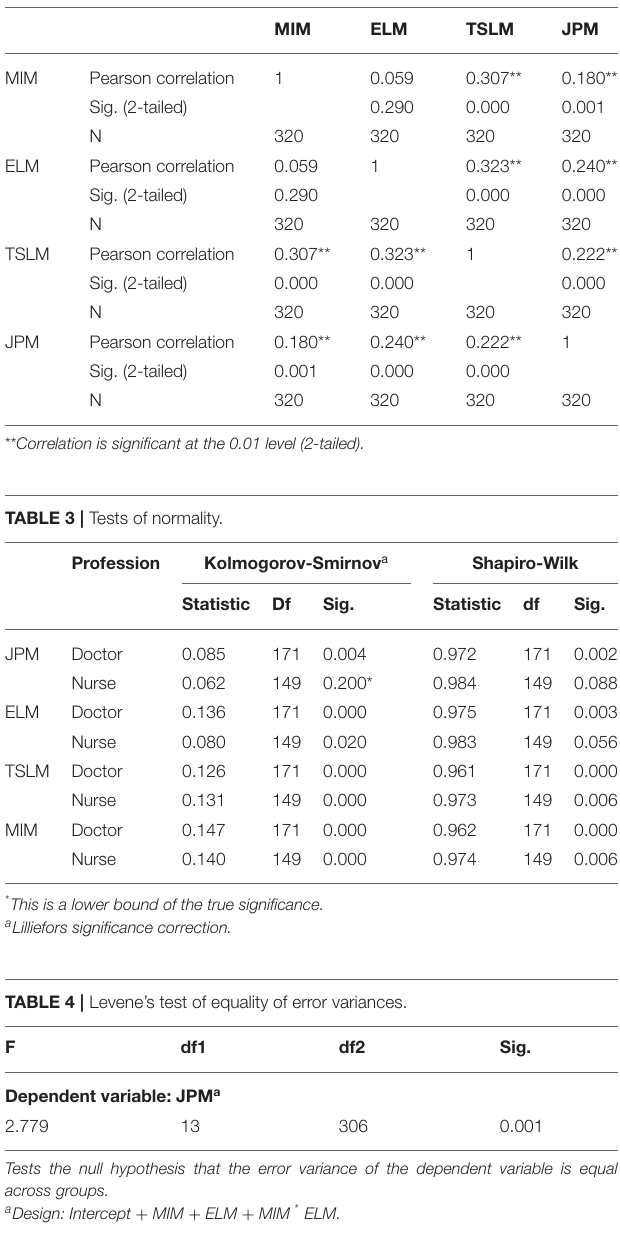
TABLE 2 | Correlation matrix.